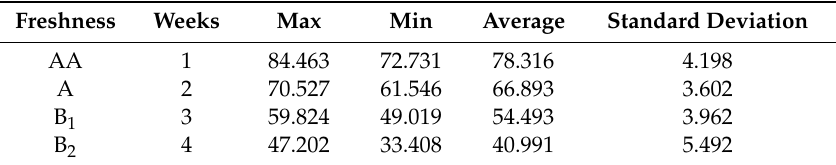
Table 1. Distribution of egg Hastelloy.